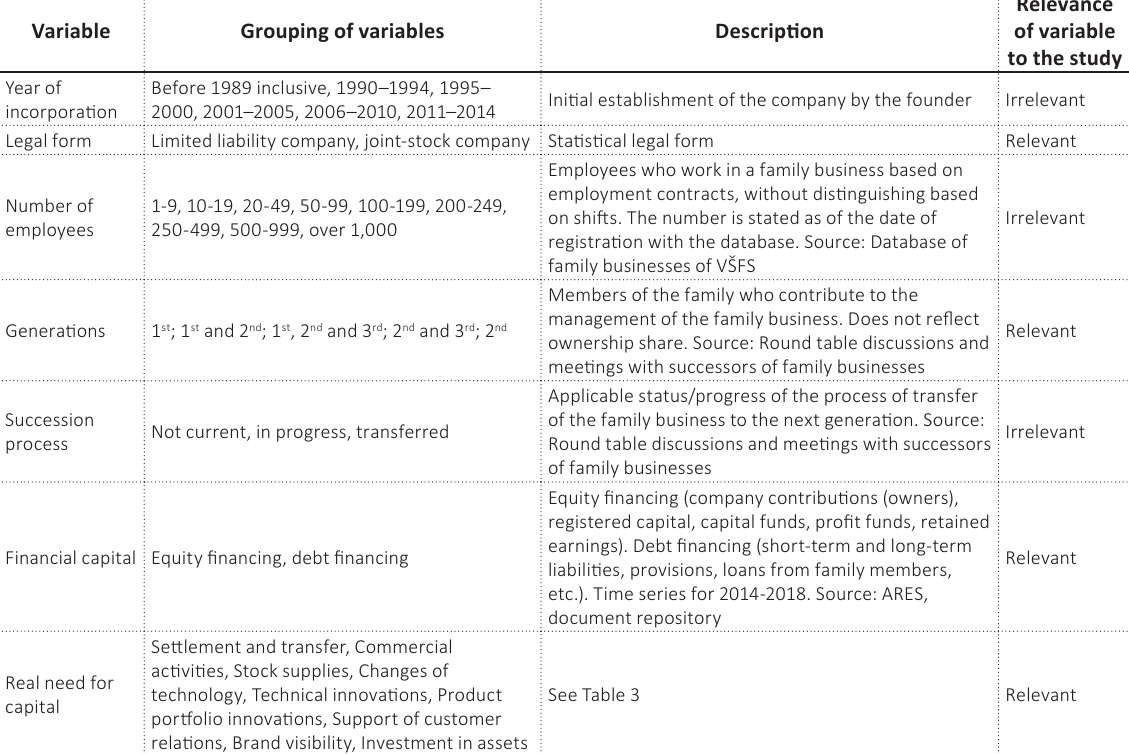
Table 2. Description of the study